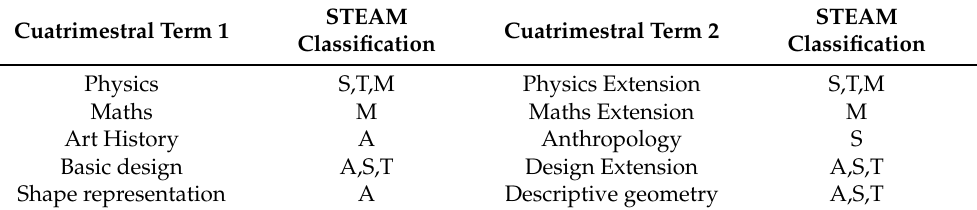
Table 3. First-year subjects of design engineering